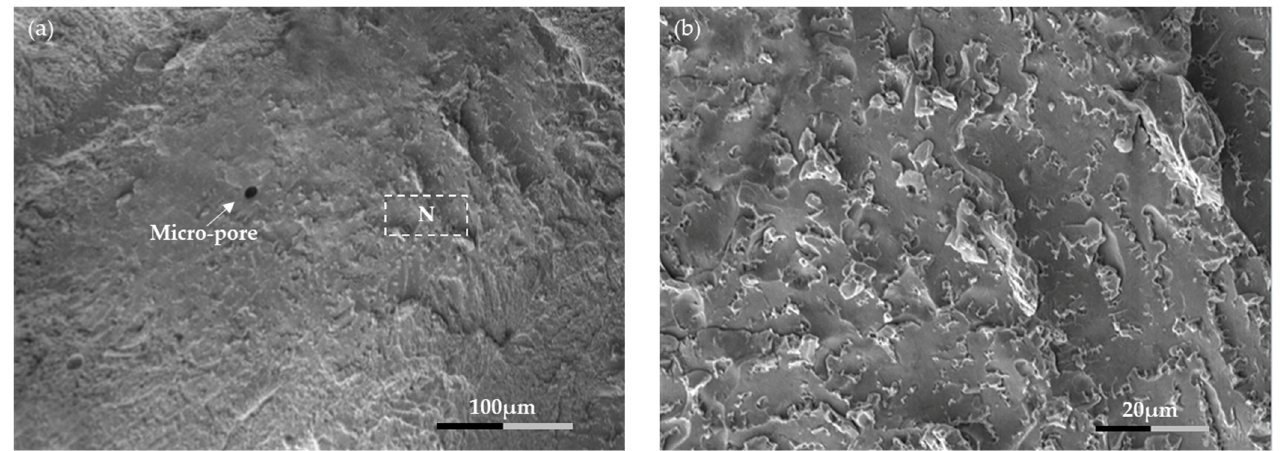
Figure 11. SEM image of fracture interface in fracture mode I: ( a ) Fracture surface on Ti 2 AlNb side; ( b ) High magnification image of M.